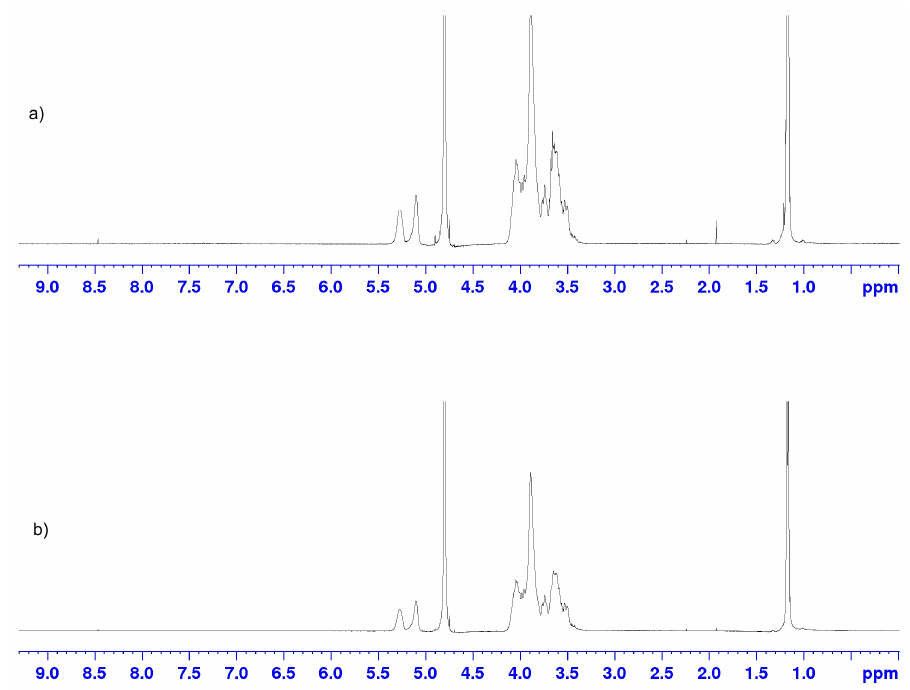
Figure 14. 1 H-NMR spectrum: ( a ) complex of curcumin: 2-hydroxypropyl- β -cyclodextrin and ( b ) 2-hydroxypropyl- β -cyclodextrin. Figure 14. 1H ‐ NMR spectrum: ( a ) complex of curcumin:2 ‐ hydroxypropyl ‐β‐ cyclodextrin and ( b ) 2 ‐ hydroxypropyl ‐β‐ cyclodextrin. Table 3. Chemical shifts values δ for 2-hydroxypropyl- β -cyclodextrin (2-HP- β -CD) and for complex of curcumin: 2-hydroxypropyl- β -cyclodextrin (Complex) and changes in chemical shifts ∆ δ for Table 3. Chemical shifts values δ for 2 ‐ hydroxypropyl ‐β‐ cyclodextrin (2 ‐ HP ‐β‐ CD) and for complex protons originate from 2-hydroxypropyl- β -cyclodextrin in complex. of curcumin:2 ‐ hydroxypropyl ‐β‐ cyclodextrin (Complex) and changes in chemical shifts  δ for pro ‐ tons originate from 2 ‐ hydroxypropyl ‐β‐ cyclodextrin in complex.